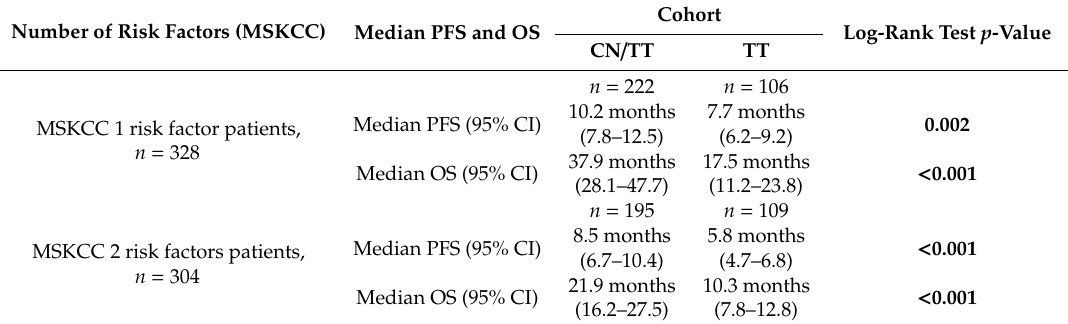
Table 3. Progression-free survival and overall survival from first treatment